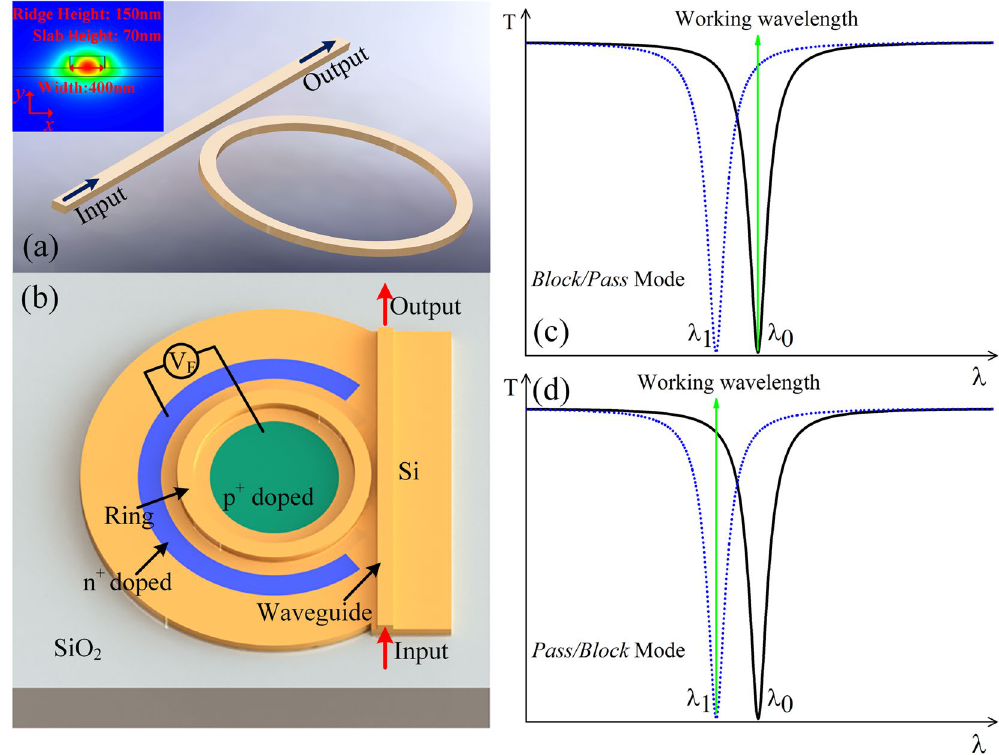
Figure 1. ( a ) Single MRR with one waveguide (inset: the cross-section of the device including the quasi-TE fundamental mode and dimensions of waveguide), ( b ) a tunable MRR-based optical switch with a PIN junction embedded in the ring, ( c ) the transmission spectra of the optical switch in block / pass mode (the status of the optical switch is from OFF to ON) for light with the working wavelength, black line is the spectra when the logic signal is ‘0’, blue line is the spectra when the logic signal is ‘1’, λ 0 marks the resonant wavelength without modulation, λ 1 marks the resonant wavelength after modulation, ( d ) the transmission spectra of the switch in pass / block mode (the status of the optical switch is from ON to